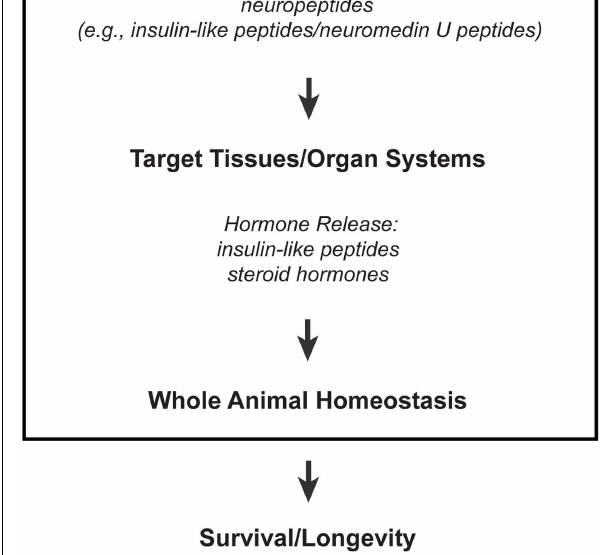
FIGURE 1 |A model for how the nervous system processes environmental information through neuronal and non-neuronal circuits to maintain homeostasis for optimal survival . Information processing of environmental inputs at the neuronal level will involve the function of (1) small molecule neurotransmitters and neuropeptides, such as insulin-like peptides, (2) stress-sensing pathways, and (3) mitochondria-associated signals.These neuronal signaling outputs will in turn target other tissues to regulate the production of secondary signals, like hormones, and thus promote homeostasis and longevity. Insulin-like peptides can function either as short-range peptide neurotransmitters (Chen et al., 2013) or as peptide